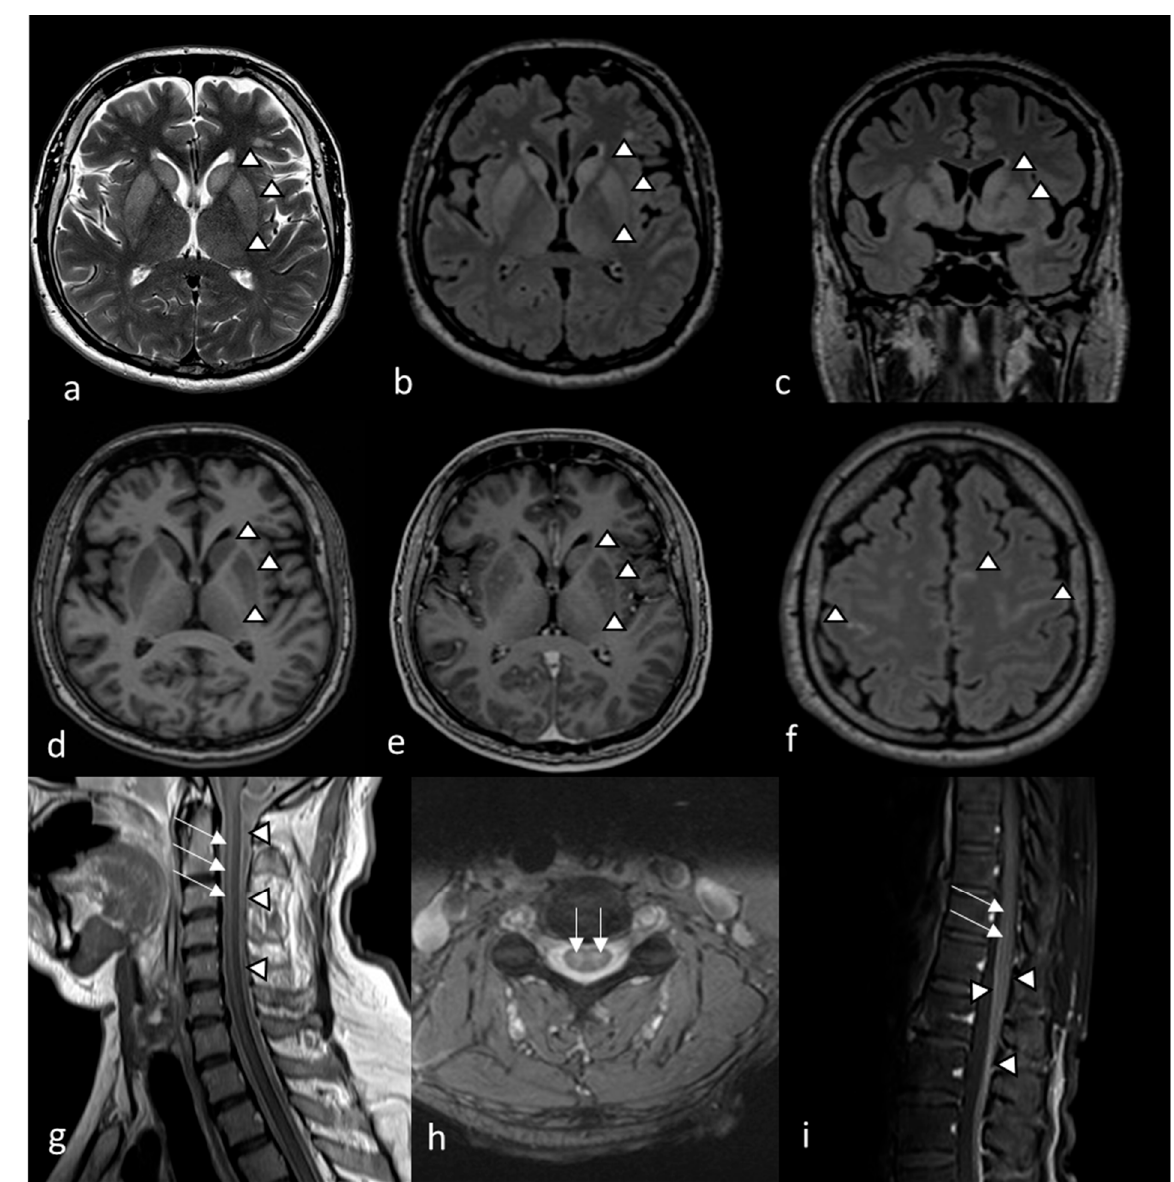
Figure 1. MRI findings on the 14th day of illness in a patient with TBE. The MRI showed symmetric diffuse T2wi ( a ) and FLAIR ( b ). Hyperintensity of the basal ganglia, especially the putamen and caudate nucleus, with a slightly less pronounced increase in the signal of both thalami (arrowheads) on axial ( a , b ) and coronal ( c ) images, consistent with edema. Bilaterally decreased T1wi signal in the putamen and caudate nucleus ( d ) followed by patchy contrast enhancement ( e ) on axial images (arrowheads), implying basal ganglia inflammatory lesions. Meningeal contrast enhancement on FLAIR ( f ) and leptomeningeal contrast enhancement in the cervical medulla ( g ) and medullary cone ( i ), correlating with meningeal/leptomeningeal inflammation (arrowheads). Symmetric T2wi signal increase found in cervical medulla ( h ) with contrast enhanced areas delineated in cervical ( g ). Lumbar spinal cord ( i ) correlating with myelitis (arrows).